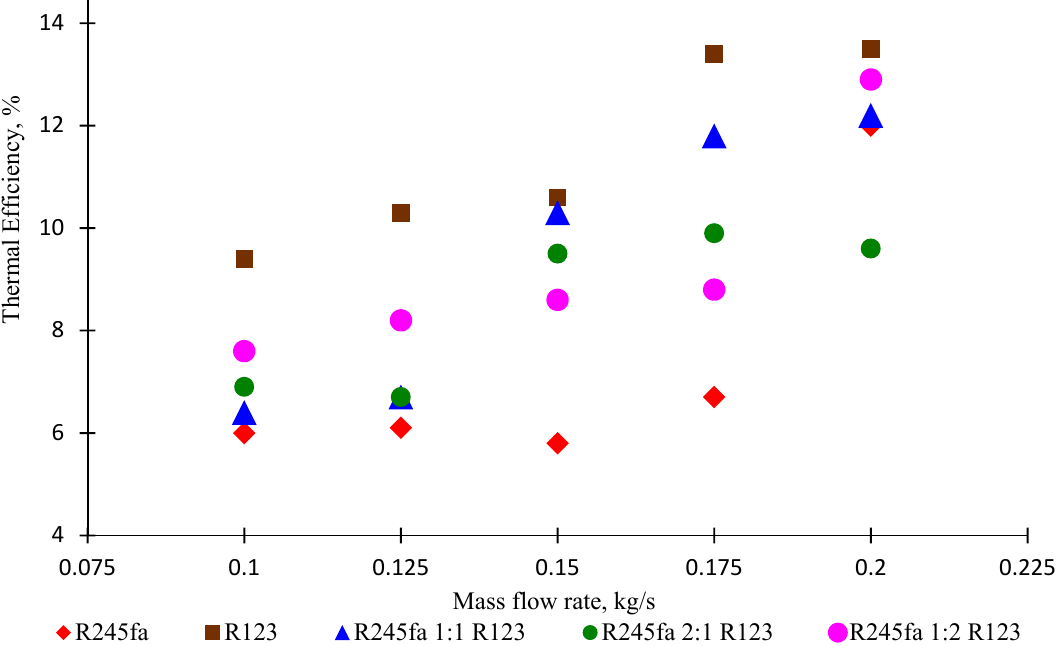
Figure 21. Efficiency ORC as a function mass flow rate for R245fa, R123, and mixed working fluids with heat source at 120 ° C.